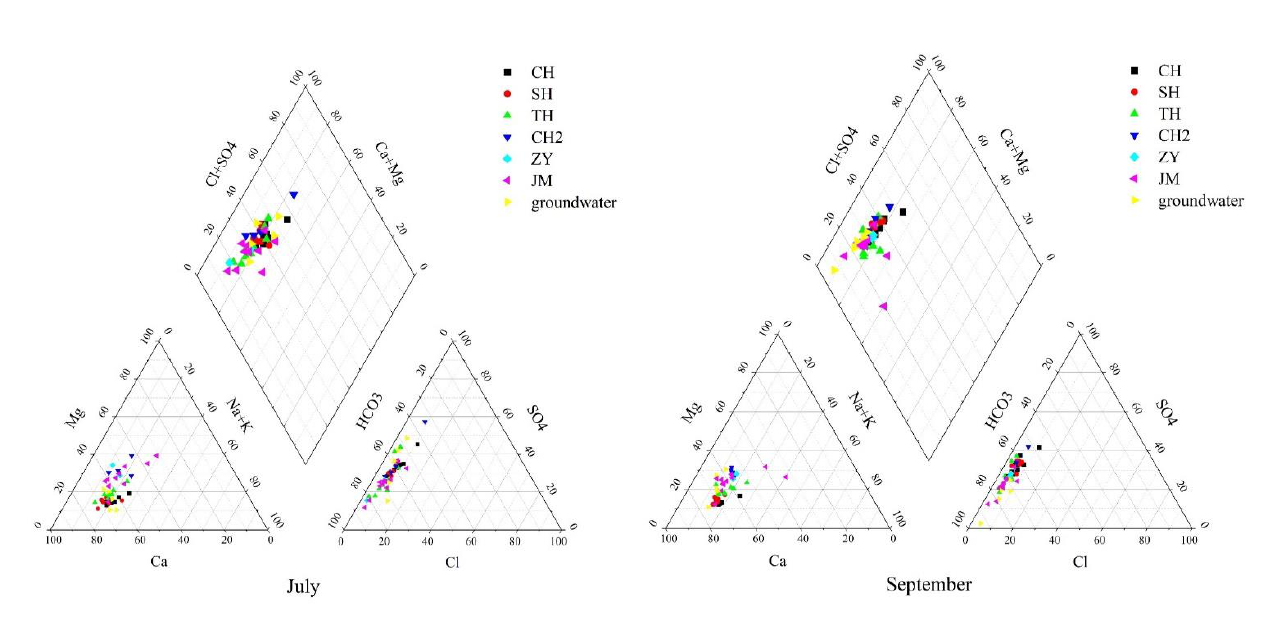
Figure 3. Chemical Piper diagram of surface water samples taken before and after the rainy season in the mountainous watershed of Daqing River (CH—Ci river, SH—Sha river, TH—Tang river, CH2—Cao river, ZY—Zhongyi river, JM—Juma river).